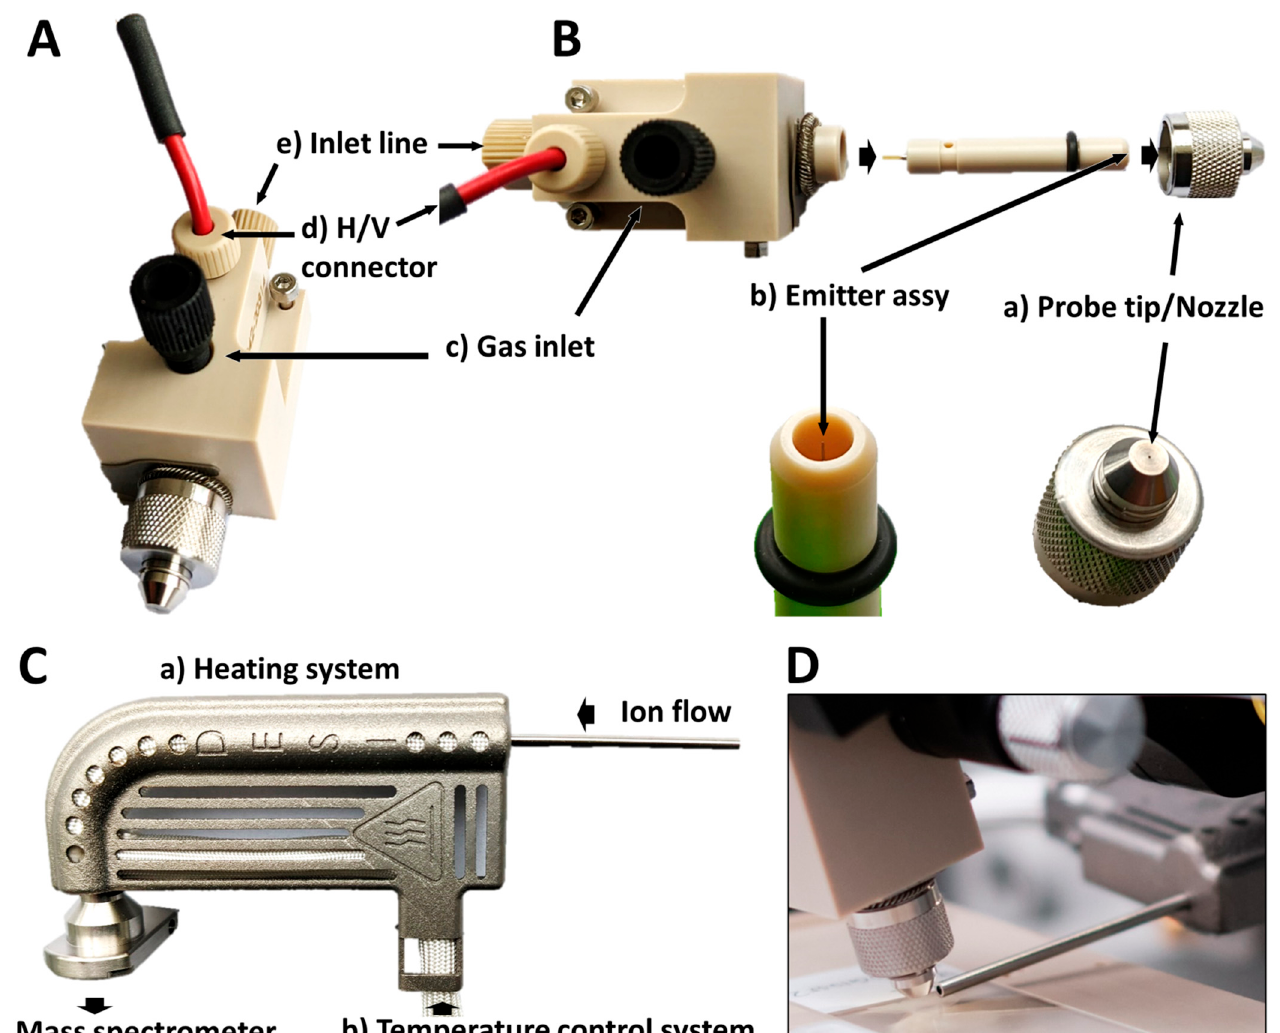
Figure 7. Architecture of the High Performance (HP) DESI Sprayer and the Heated Transfer Line. ( A ) Outer view and ( B ) inner view of the HP DESI Sprayer showing the location of the emitter and the critical connections (H/V, gas and fluid inlet line). ( C ) Heated Transfer Line showing the heating system and the position of the temperature control system. ( D ) Complete setup installed on the mass spectrometer.